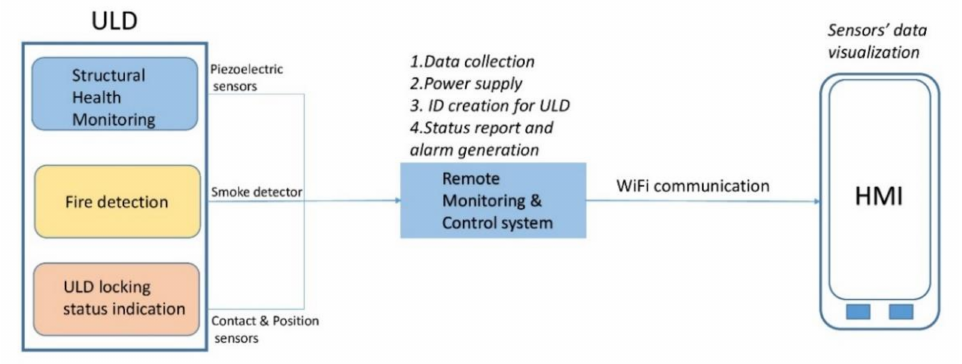
Figure 1. The remote monitoring and control system